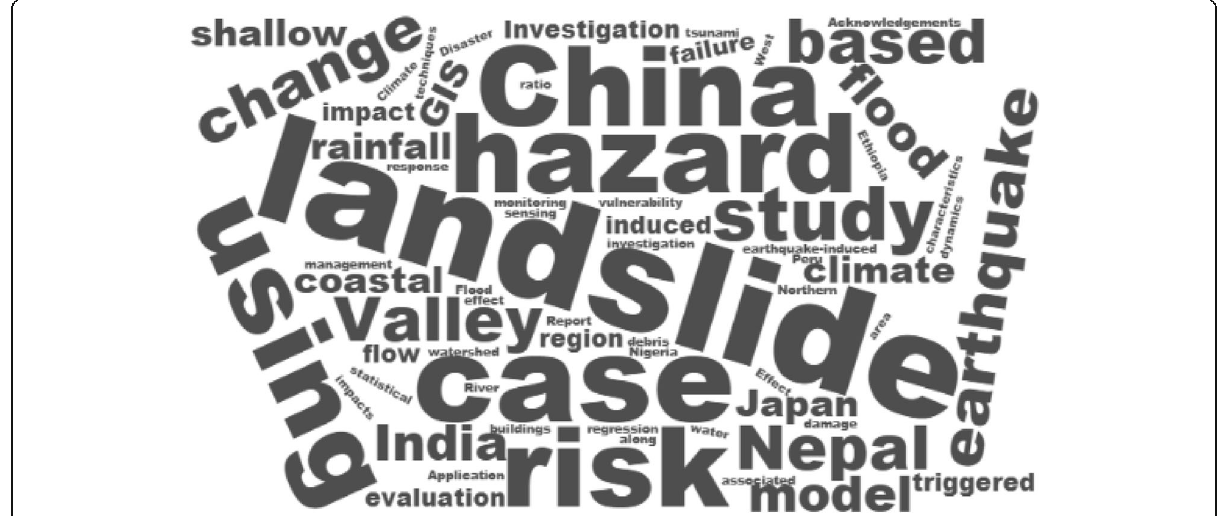
Fig. 1 Word cloud representation of the most frequently used words in the titles of 115 analysed papers. Only words occuring three times or more are displayed ( n = 80). The size of the font indicates the frequency of occurrence (3 – 48